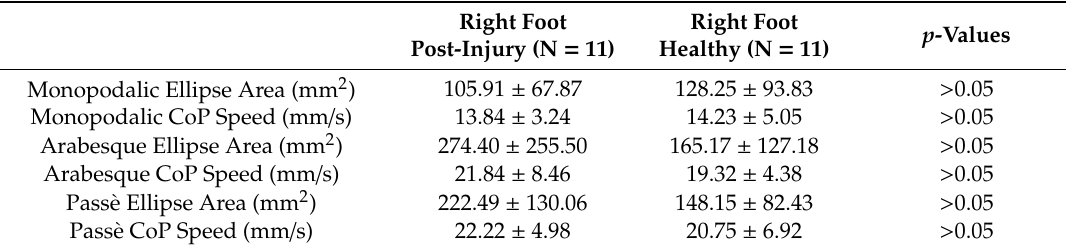
Table5. Comparisonbetween rightfeetof pathologicalandhealthy subjectsfor stabilometric parameters acquired with open eyes.